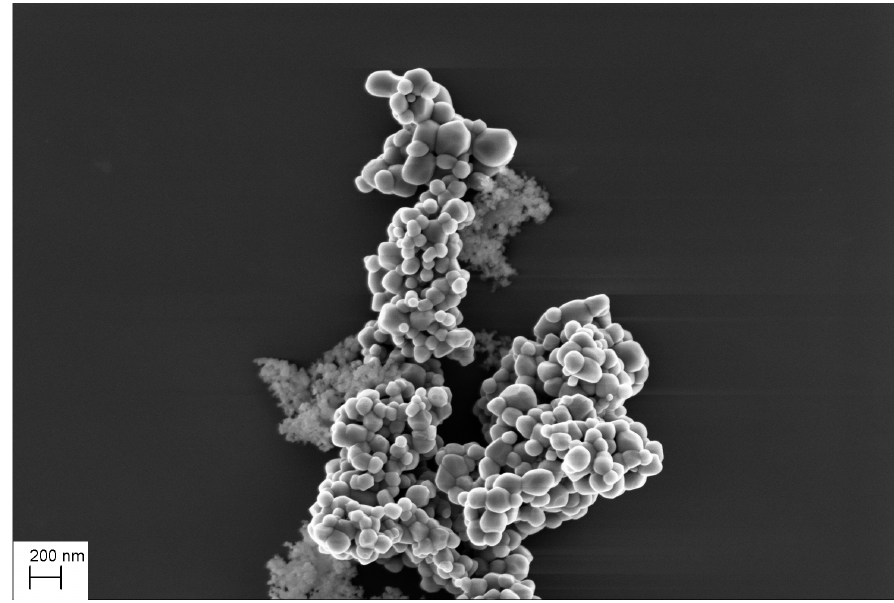
Figure 1. Example of the SEM image of a mixture of TiO 2 and SiO 2